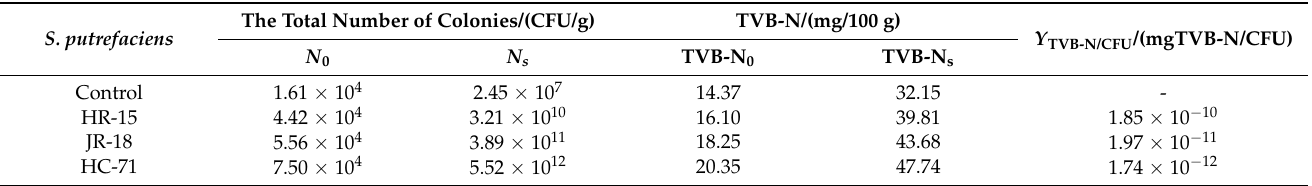
Table 3. The yield factors of the TVB-N of the fish fillets inoculated with different S . putrefaciens strains (HR-15, JR-18, and HC-71) during chilled storage at 4 ◦